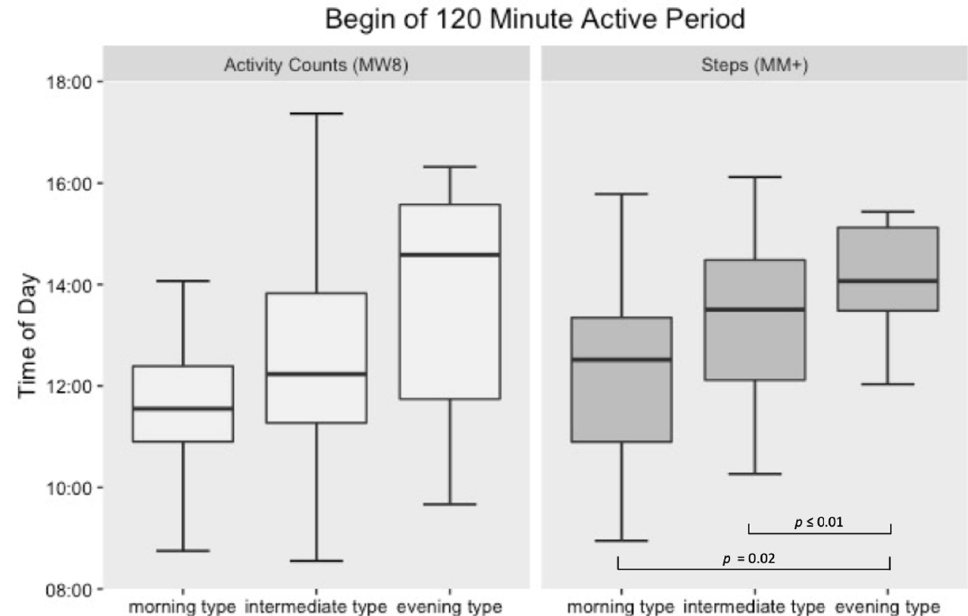
Figure 3. Box-plot illustration of 120-min active periods beginnings in relation to the subjectively rated chronotypes.